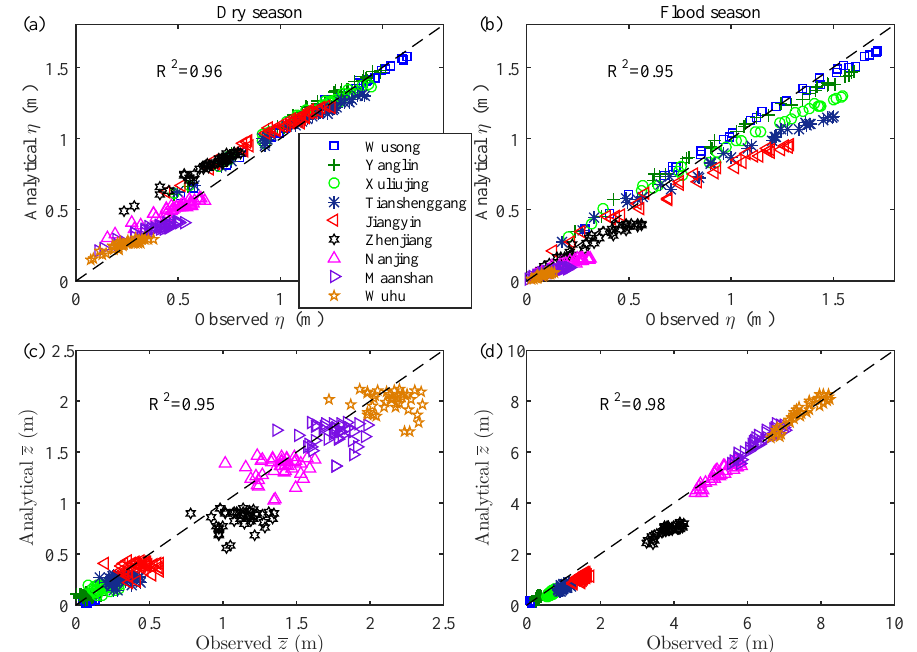
Figure 9. Comparison between analytically computed tidal amplitude η (a, b) and residual water level z (c, d) and measurements in the Yangtze estuary during 6–26 February 2012 – (a, c) , representing the dry season, and during 10–26 August 2012 – (c, d) representing the flood season.